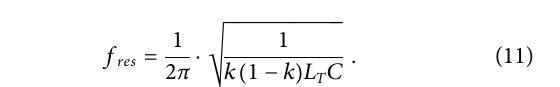
Figure 4A is a diagram of the relationship between f res and k at undamped oscillation frequency, which shows that the resonance frequency is the lowest when k is 0.5.